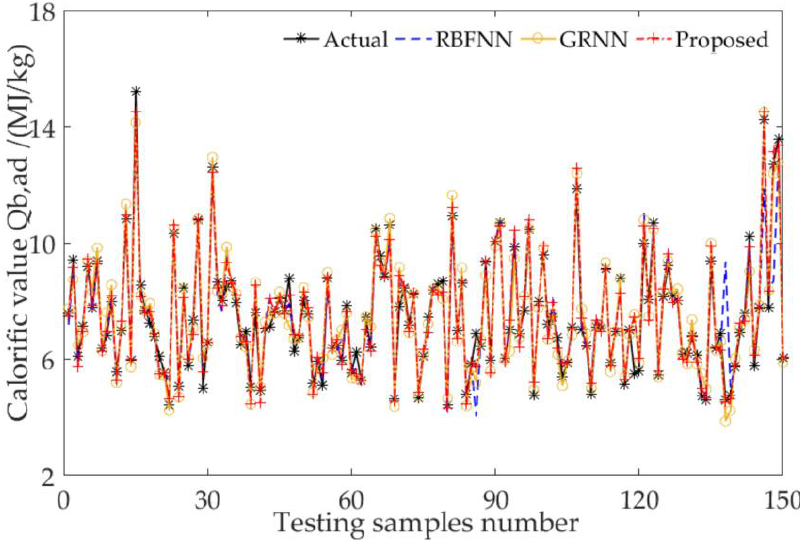
Figure 11. APE distribution of forecasted calorific value ( Q b,ad ) by a hybrid kernel function. Moreover, the forecasting performance of the HKF-SVR with other conventional methods (including generalized regression neural network and radial basis function neural network) are compared to further demonstrate the superiority of the proposed approach. The forecasted calorific values ( Q b,ad ) by RBFNN, GRNN and HKF-SVR are displayed in Figure 12 and Table 6.